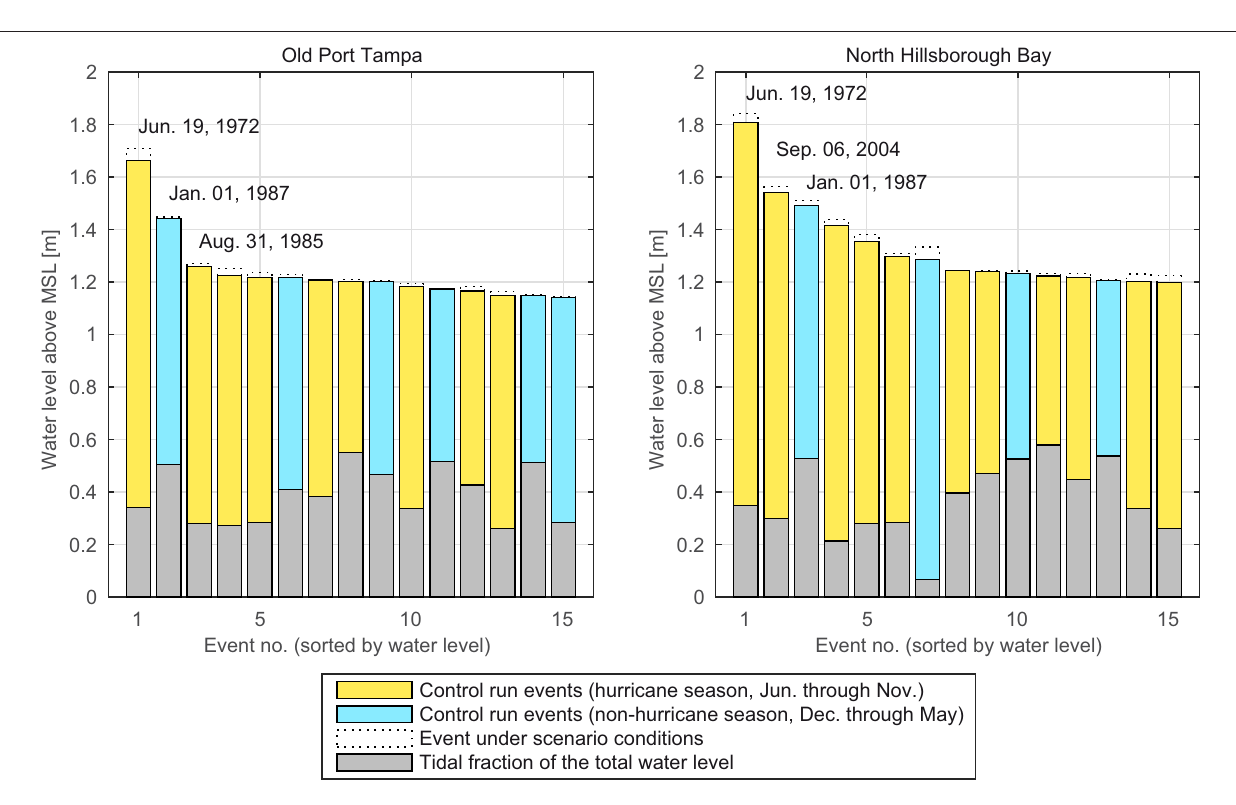
FIGURE 11 | Comparison of the 15 largest events (by total still water level under control run conditions) in northern Tampa Bay. Yellow bars indicate storm surges during the tropical season (June through November), blue bars indicate all other events (e.g., winter storms). The tidal contribution to the water level is depicted as gray overlay. The total water level under scenario conditions is shown as dotted bar